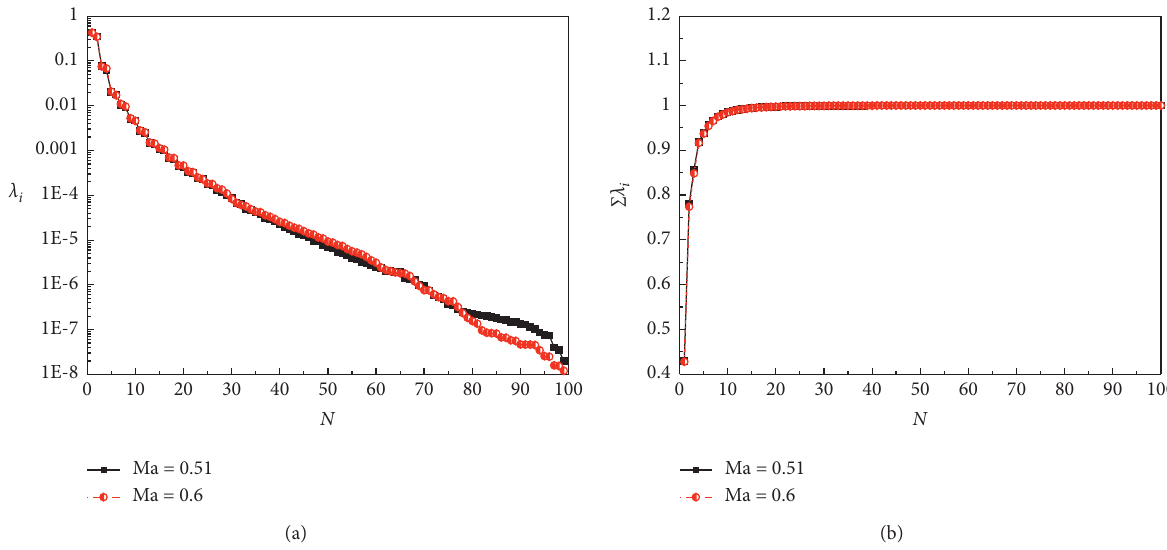
Figure 6: (a) Eigenvalues and (b) cumulative eigenvalues for cavity flow oscillations at Ma � 0.51, 0.6.